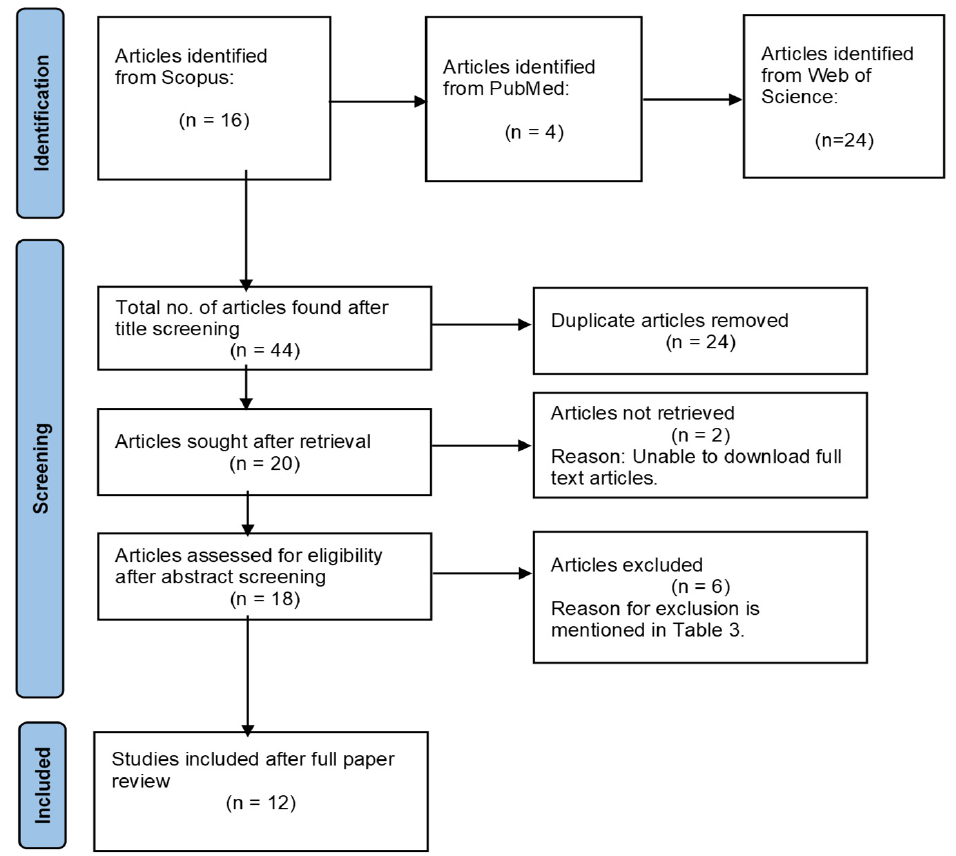
Figure 1. PRISMA flow diagram for studies